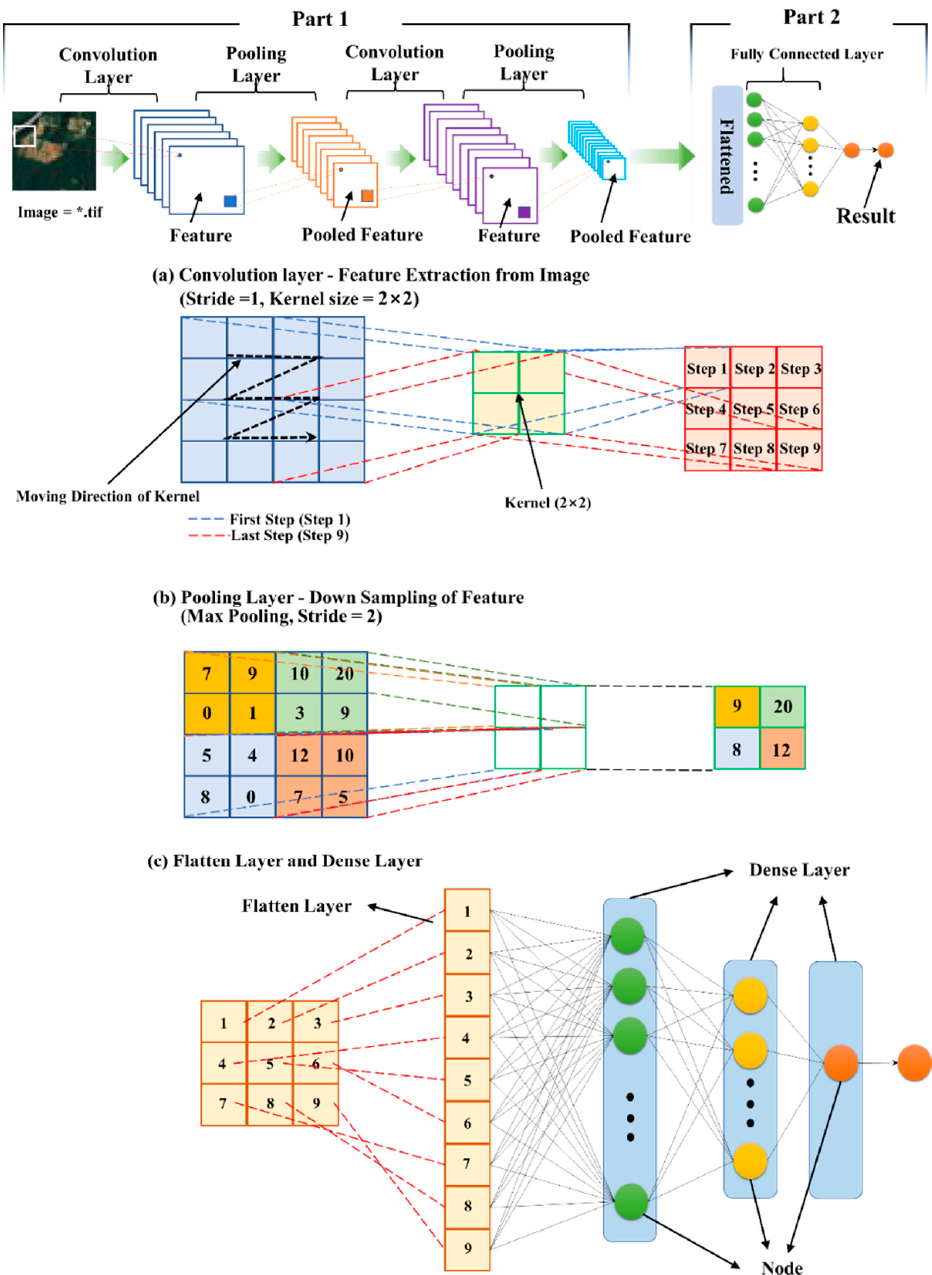
Figure 4. Scheme of the convolution neural network (CNN) Figure 4. S cheme of the convolution neural network (CNN) model.